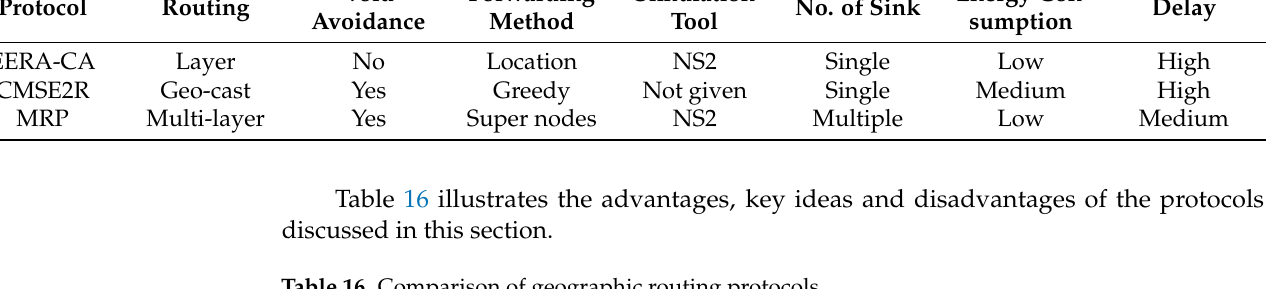
Table 16. Comparison of geographic routing